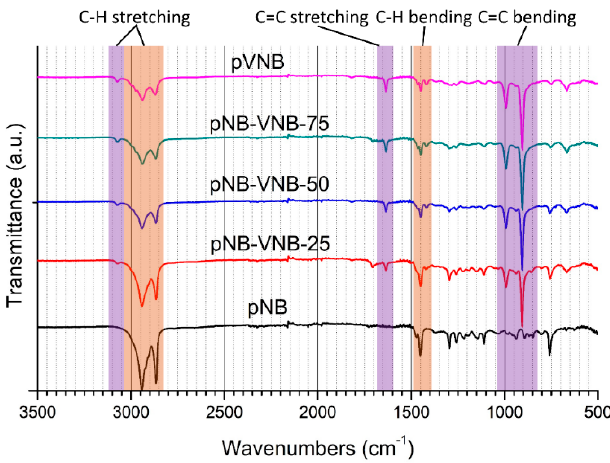
Figure 3. FT-IR of polynorbornene membranes with various amounts of VNB built in. Purple regions are unique for alkenes, while orange regions are related to saturated C–H bonds.